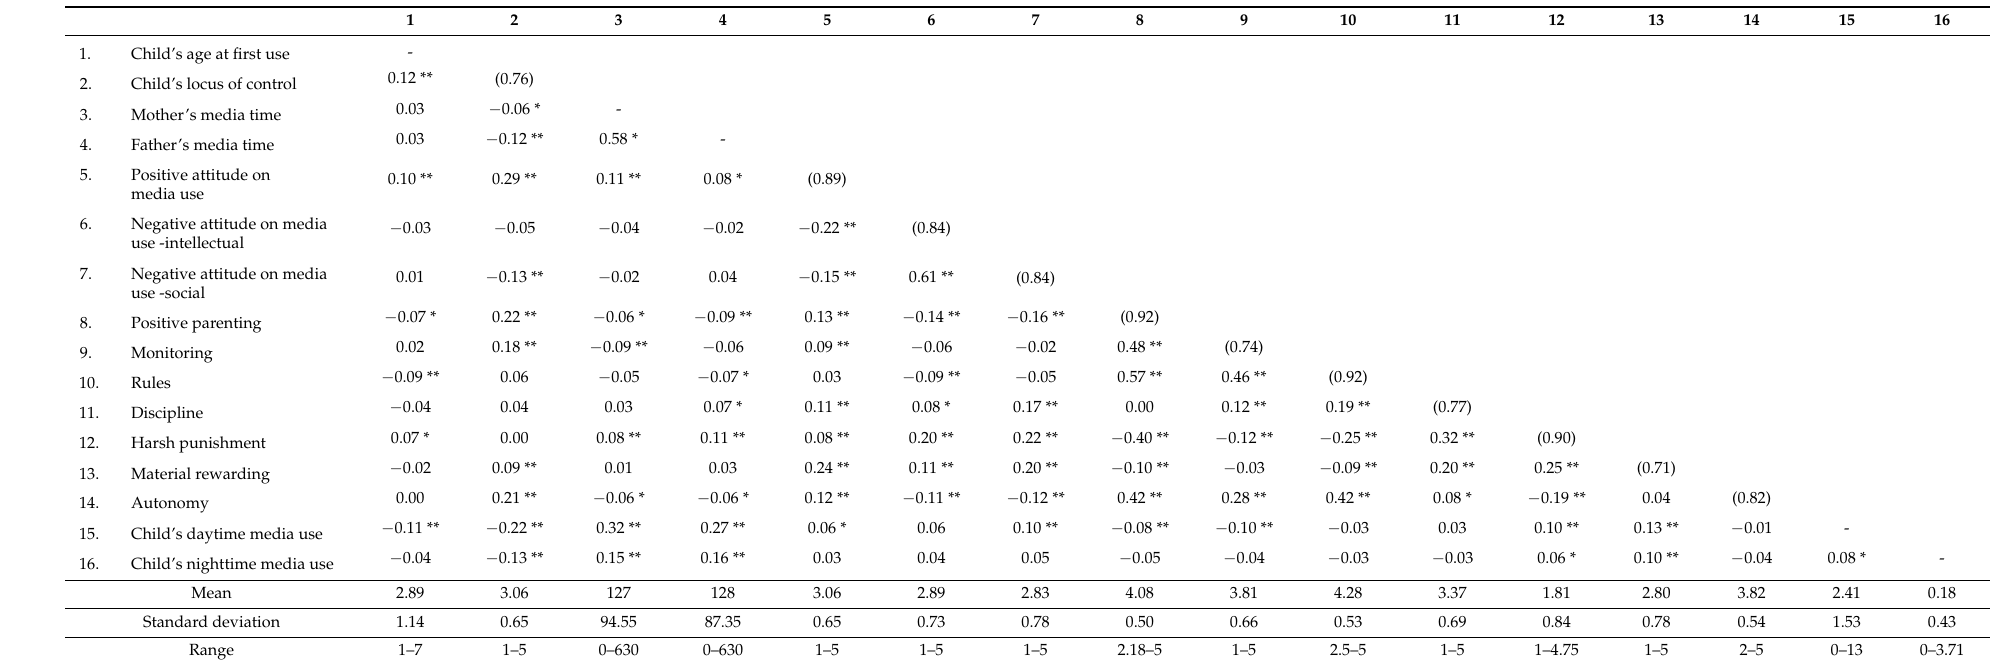
Table 1. Reliabilities, correlations, means, and standard deviations of the main